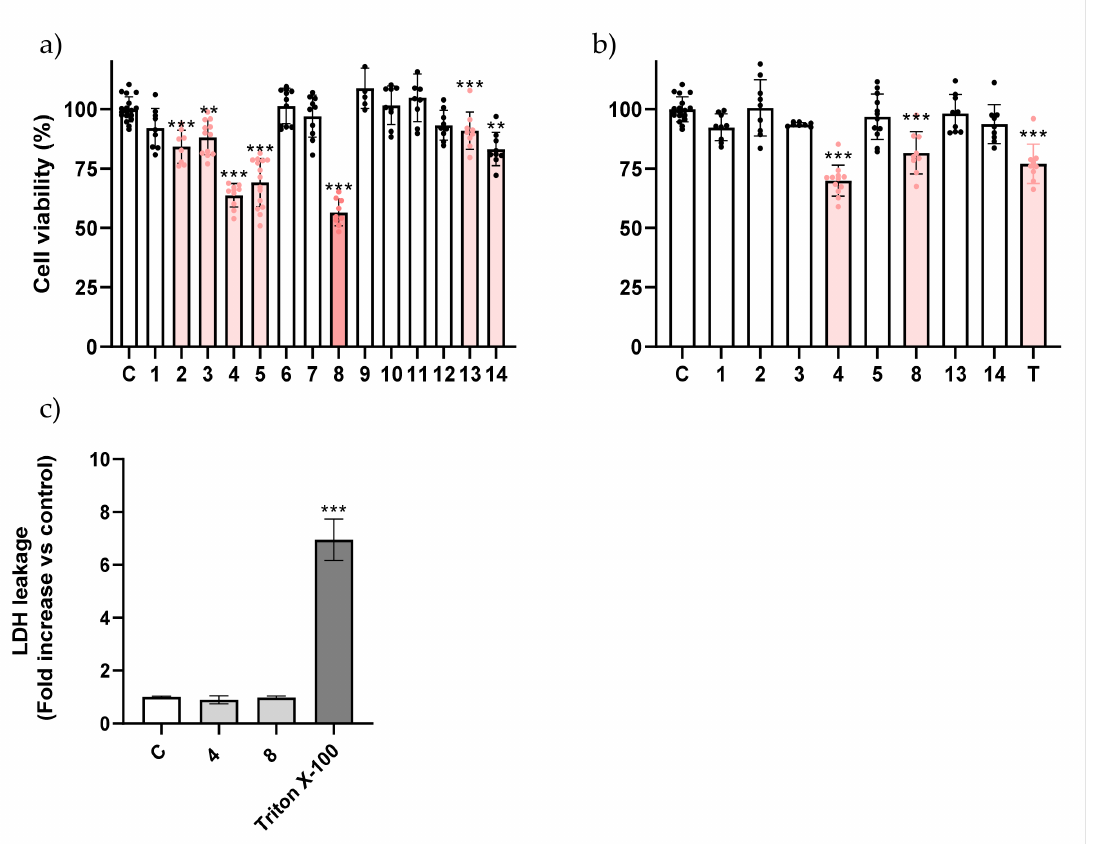
Figure 2. Viability of A549 cells exposed to the molecules at 200 µ M ( a ) and 100 µ M ( b ). The effect of topotecan at 5 µ M is also presented in ( b ). ( c ) Influence of molecules 4 and 8 at 100 µ M on membrane integrity of A549 cell line after 24 h. Triton X-100 at 1% was used as a positive control for maximum extracellular LDH activity. Each dot represents a single determination. C: control; T: topotecan. ** p < 0.01 *** p < 0.001.